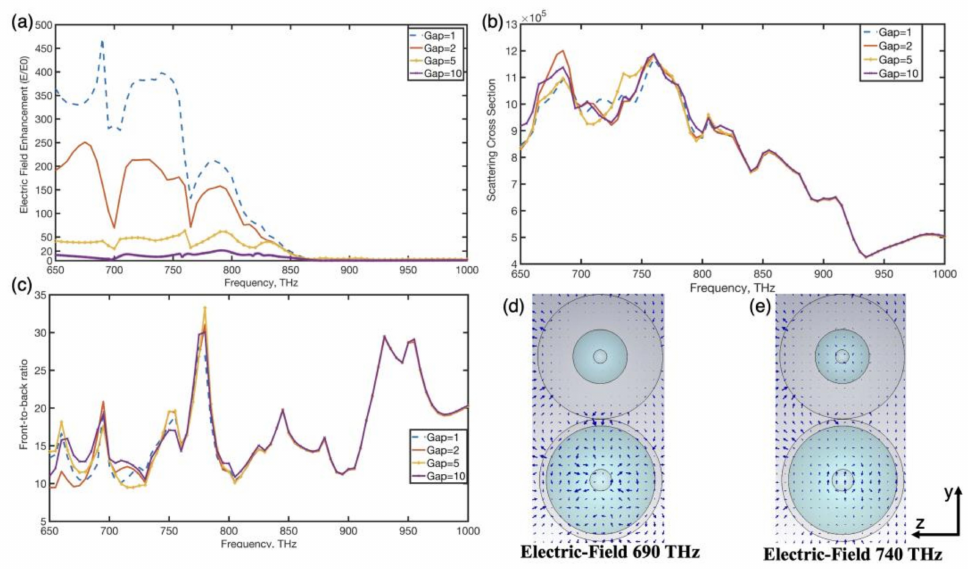
Figure 3. Electric near-field enhancement ( a ), scattering cross-section ( b ) and front-to-back scattering ratio ( c ) of the hybrid dimer for different separating distances in the gaps as a function of frequency. Additionally, inset distributions of ( d , e ) show absolute value of the electric field (gap width = 1 nm) at the frequencies of 690 THz and 740 THz,